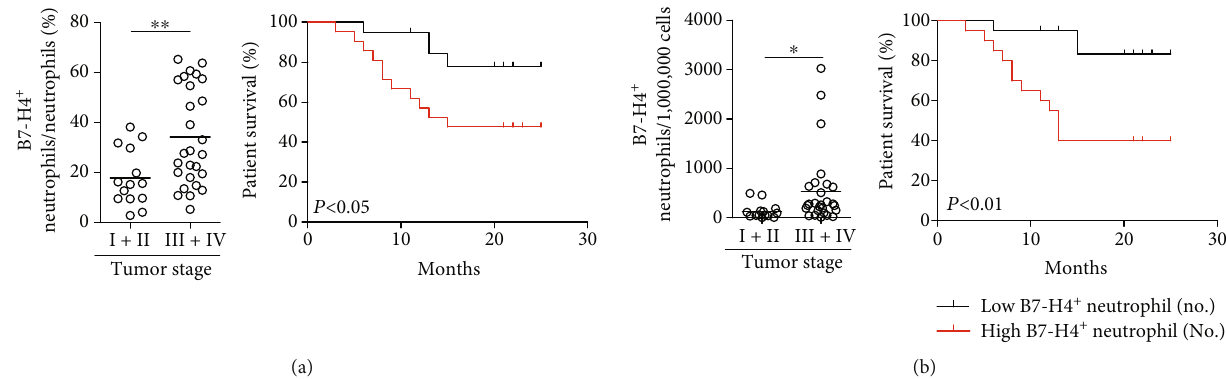
Figure 6: B7-H4 + neutrophils correlate with advanced tumor stage and poor survival in patients with GC. (a) Intratumoral B7-H4 + neutrophil percentage among TNM stages was compared. Kaplan-Meier plots for overall survival of GC patients by median intratumoral B7-H4 + neutrophil percentage (22.9%). (b) Intratumoral B7-H4 + neutrophil number among TNM stages was compared. Kaplan-Meier plots for overall survival of GC patients by median intratumoral B7-H4 + neutrophil number (196 per million). The horizontal bars in (a) and (b) represent mean values. Each ring in (a) and (b) represents 1 patient. ∗ P < 0 : 05 , ∗∗ P < 0 : 01 , and n.s. P > 0 : 05 for groups connected by horizontal